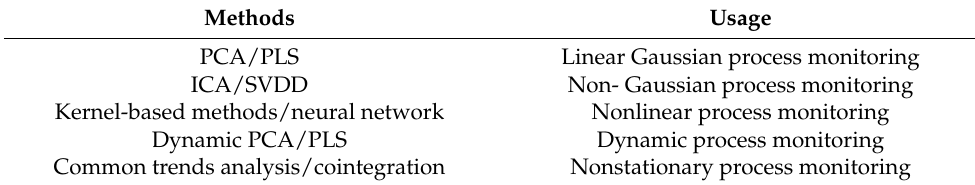
Table 2. A summary of commonly used feature extraction